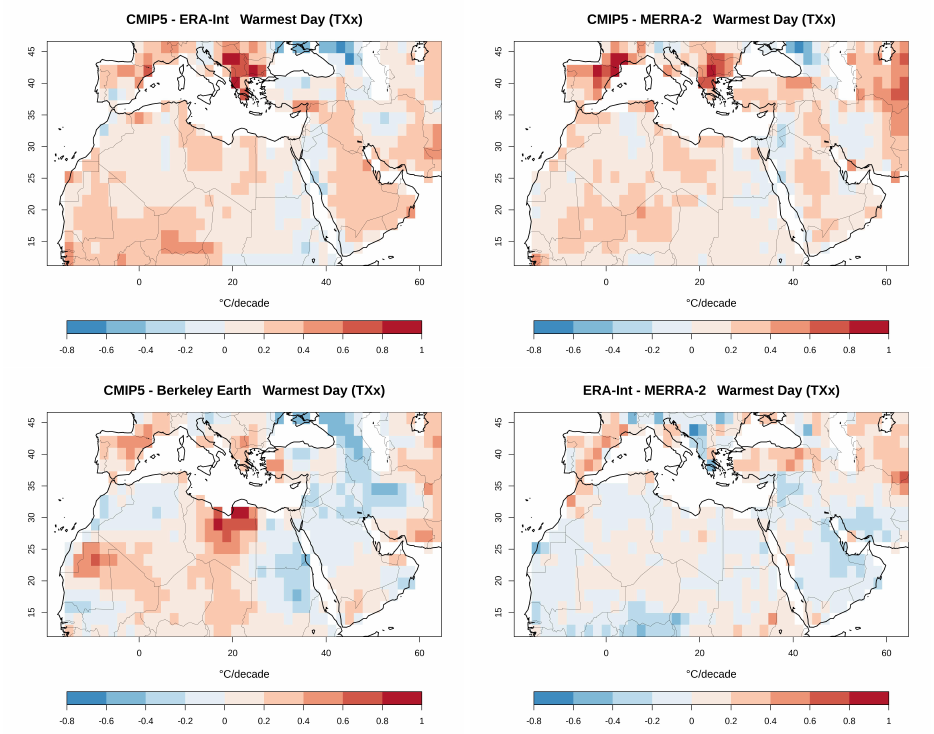
Figure A5. Maps of differences for the 1980–2018 decadal trend of the Warmest Day (TXx) for: CMIP5—ERA-Interim ( top left ), CMIP5—MERRA-2 ( top right ), CMIP5—Berkeley Earth ( bottom left ), ERA-Interim—MERRA-2 ( bottom right